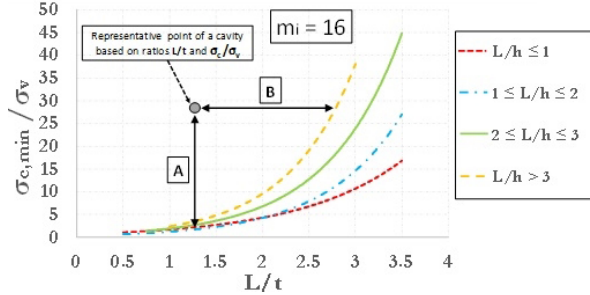
Figure 4. Curves of σ c , min /σ v against L/t for different values